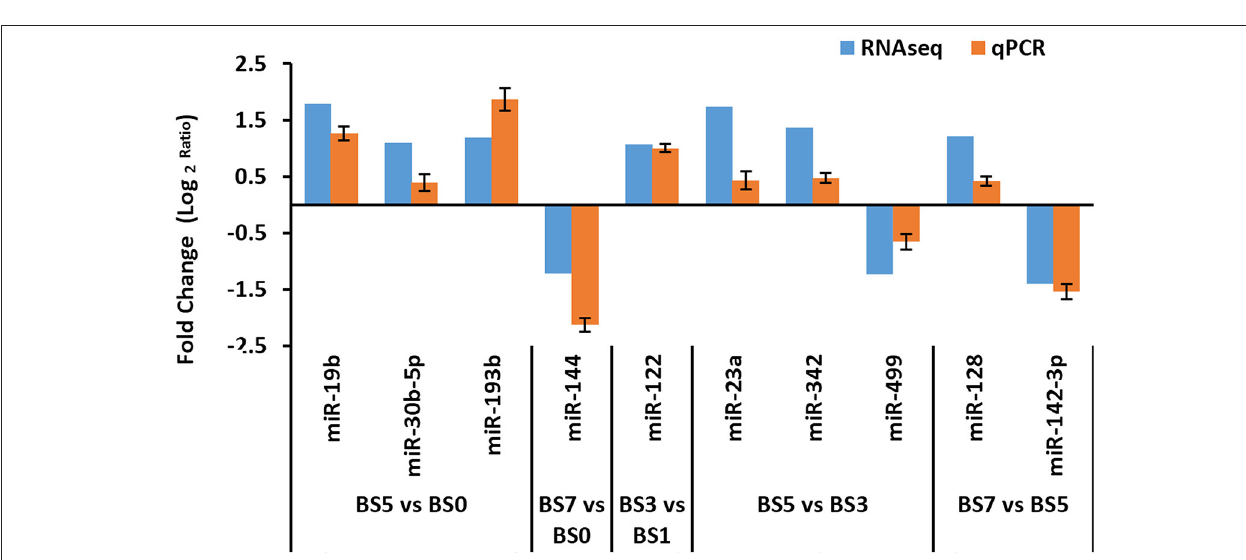
Frontiers in Veterinary Science |